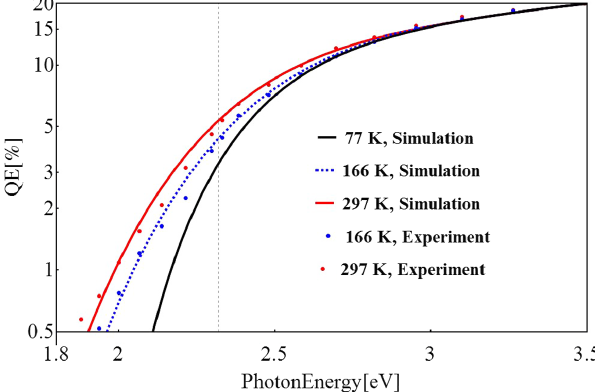
FIG. 6. The calculated curve fits with the measured spectral- response data at room temperature (red line), and at 166 K (blue, dashed). The R 2 of these two nonlinear fits are 0.99. The black curve is the expected spectral response of the cathode at 77 K. The vertical dashed line shows the QE change at 532